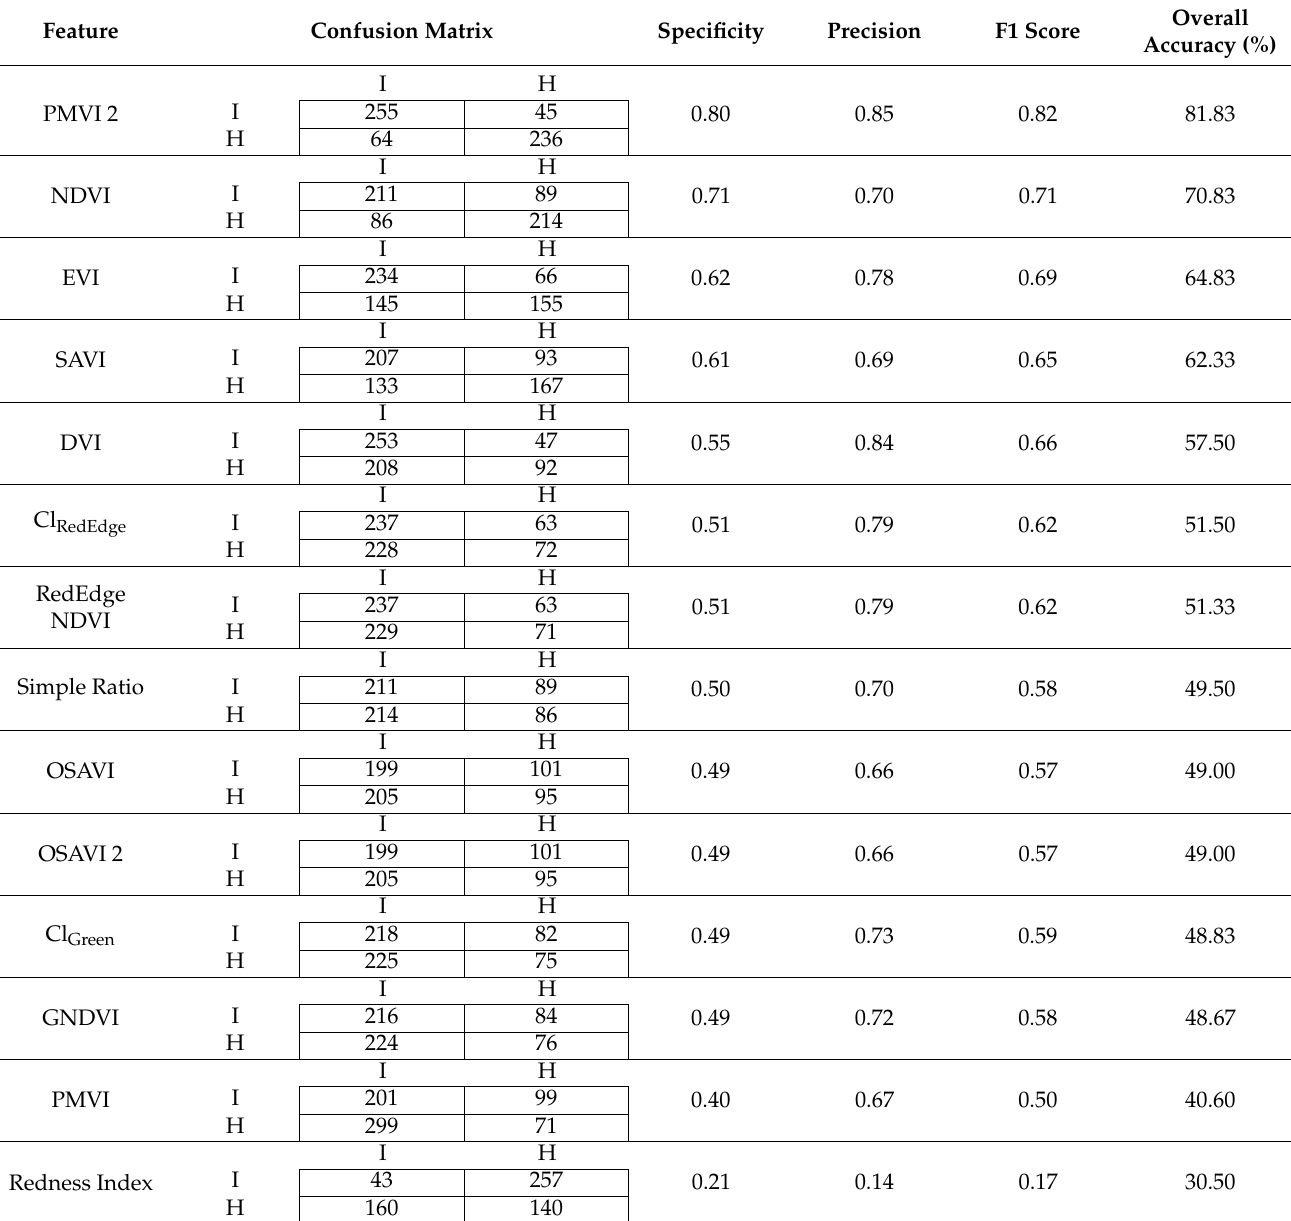
Table 5. Confusion matrix and related statistics when a fine Gaussian Support Vector Machine (SVM) classifier is validated using various spectral features computed with the Micasense© Red Edge band reflectance images to classify 300 healthy (H) and 300 infected (I) pixels from cucumber images collected inside a